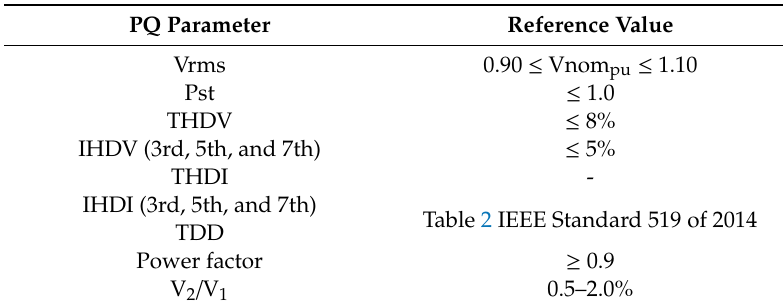
Table 2. Reference values for PQ parameters.